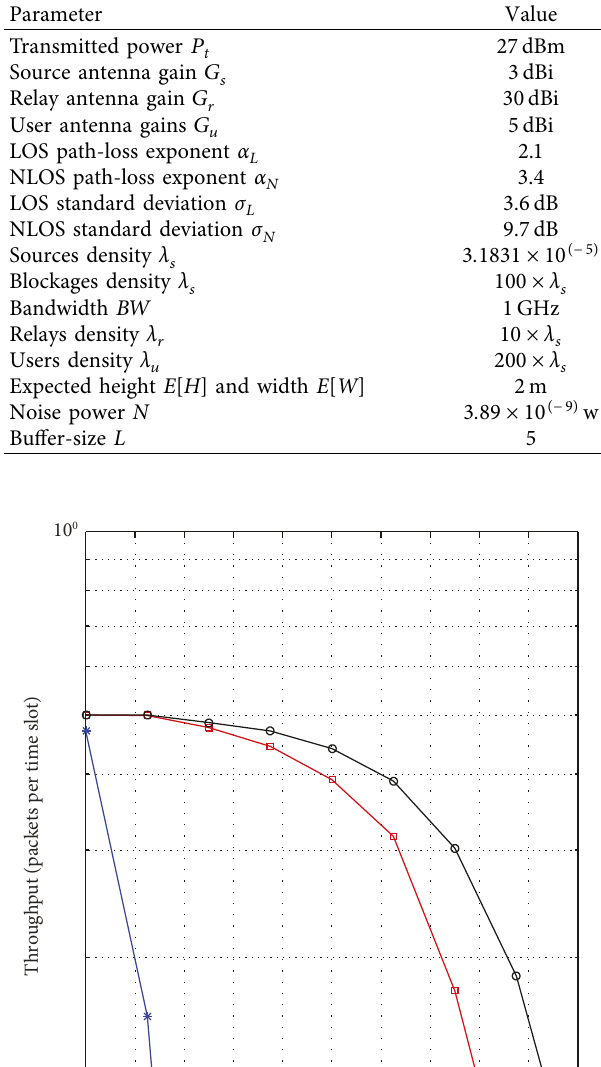
Table 1: Simulation parameter values.